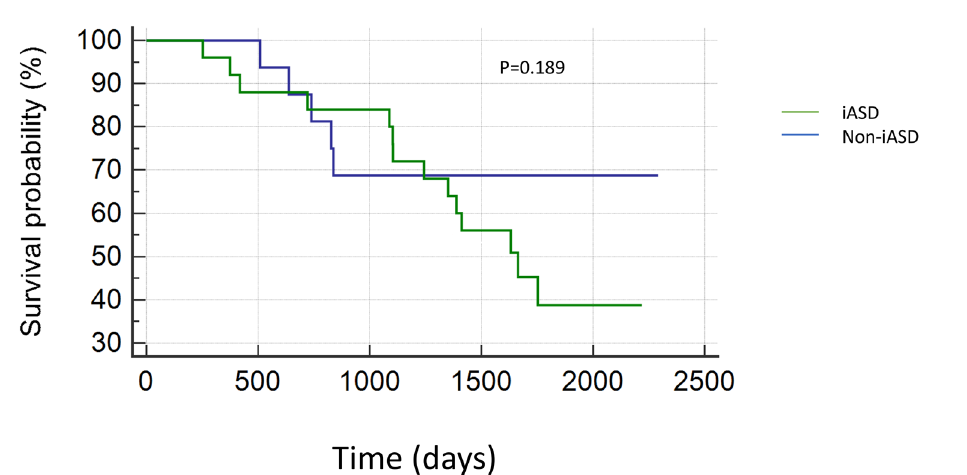
Figure 2. Comparison the rate of rehospitalization due to heart failure and mortality at 2 years follow-up between patients with and without iASD.